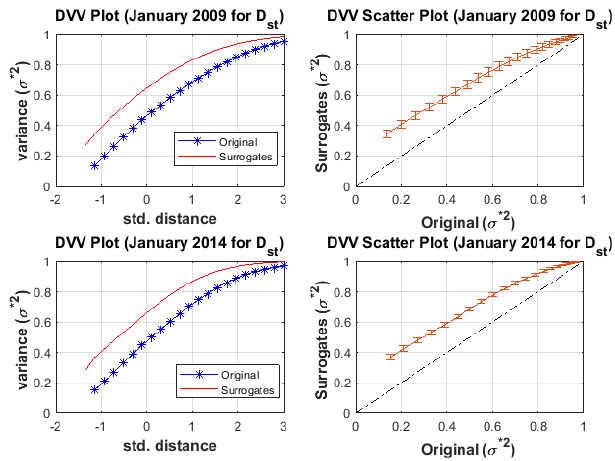
Figure 9. The DVV plot and scatter plot for D st during major geo- magnetic storm for October 2011 and December 2015.